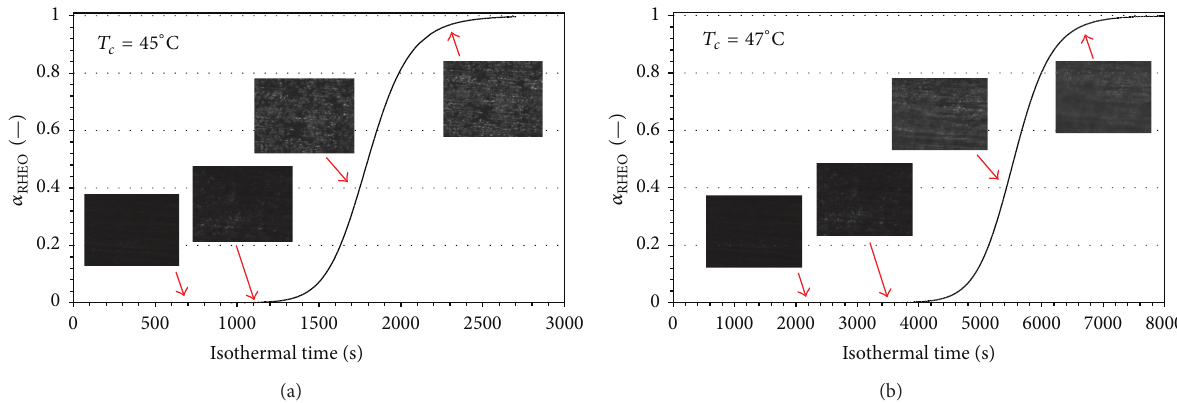
Figure 9: (a) Comparison between rheological evolution and optical morphology during isothermal crystallization of PCL at 𝑇 = 45 ∘ C. (b) Comparison between rheological evolution and optical morphology during isothermal crystallization of PCL at 𝑇 = 47 ∘